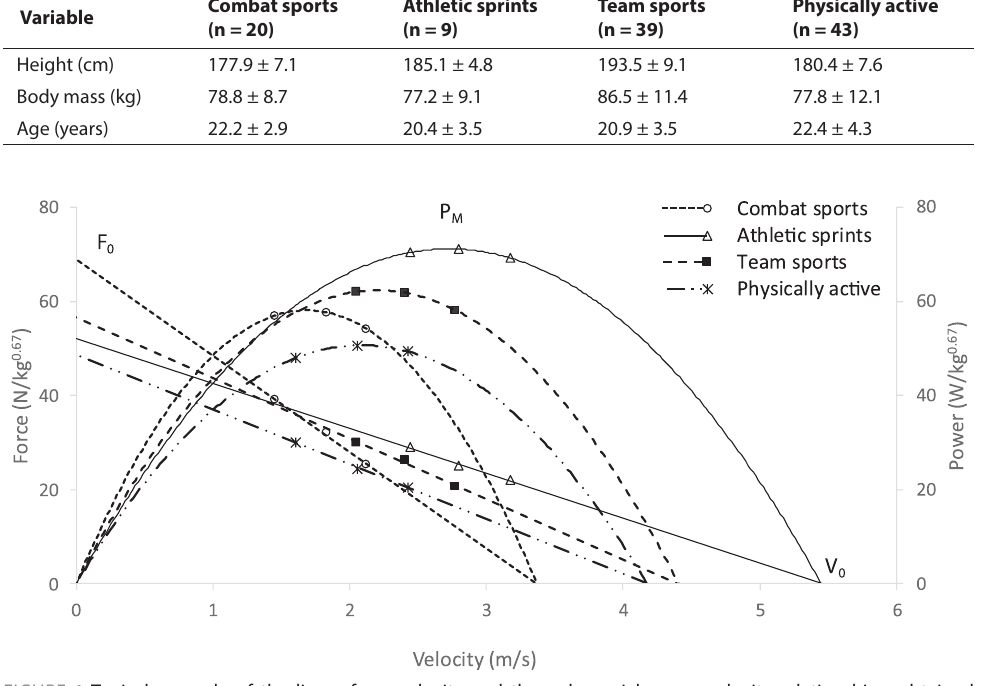
FIGURE 1 Typical example of the linear force-velocity and the polynomial power-velocity relationships, obtained during maximal sprinting on a leg friction-loaded cycle ergometer from 3 loading conditions (7%, 9%, and 11% of body weight) for representative individuals of the four